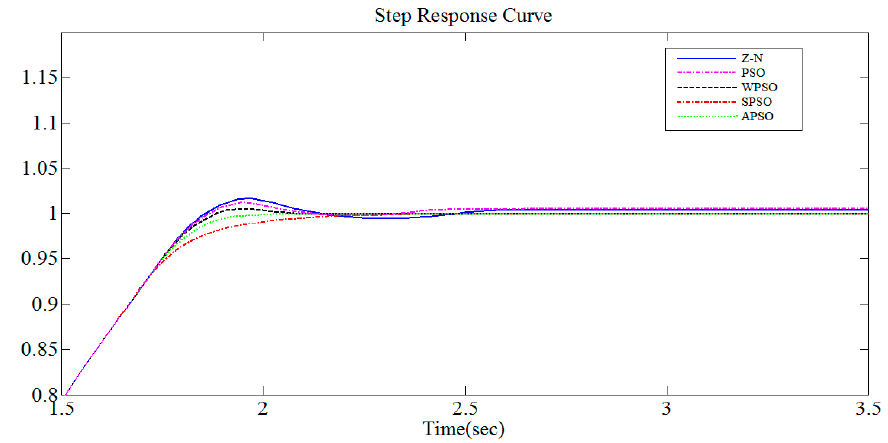
Figure 7. Comparison between the response curves derived from the step input .